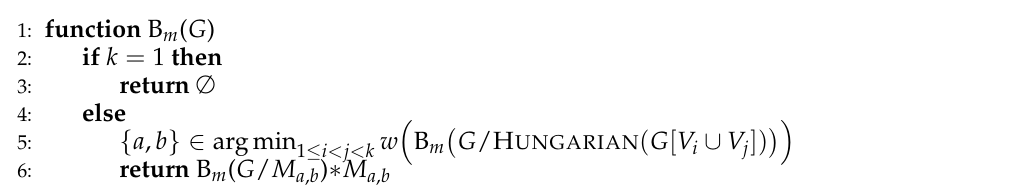
Algorithm 2 (B m , improvement of A m ).